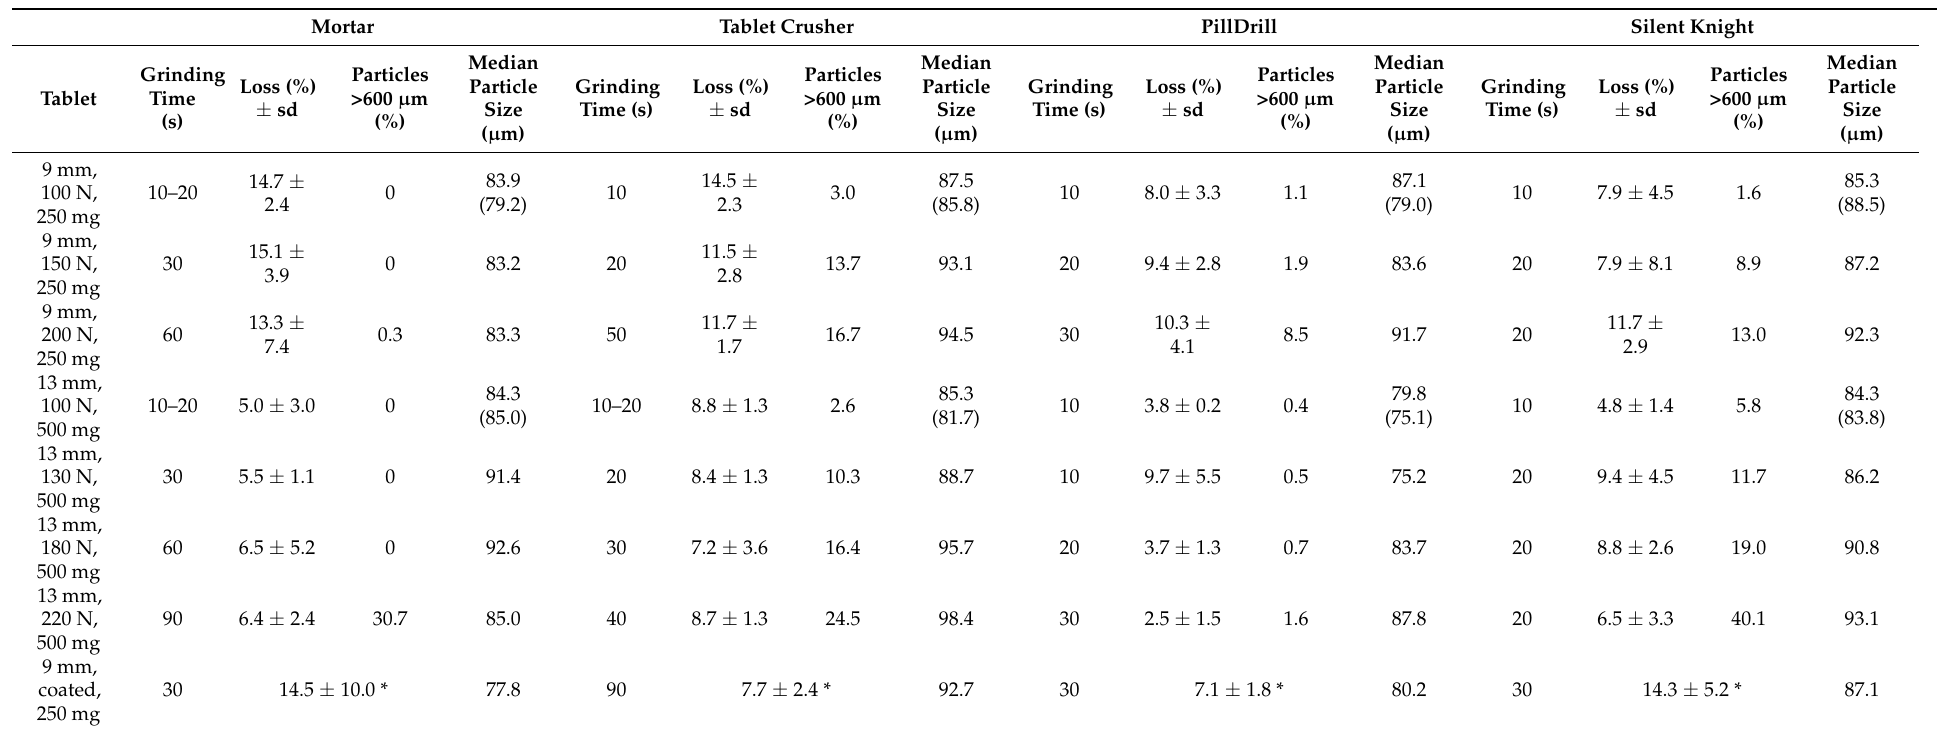
Table 4. Performance of manual grinders. Grinding time (s) is the time needed to obtain a fine powder, evaluated after 10, 20, 30, 40, 50, 60, and 90 s (six tablets, one by one). The percentage loss (mean ± sd, n = 6), the percentage particle >600 µ m of the pooled samples, and the median particle size of the pooled fraction <600 µ m are given after 1 min grinding and, for 100 N tablets only, after 2 min grinding (in brackets). Mortar Tablet Crusher PillDrill Silent